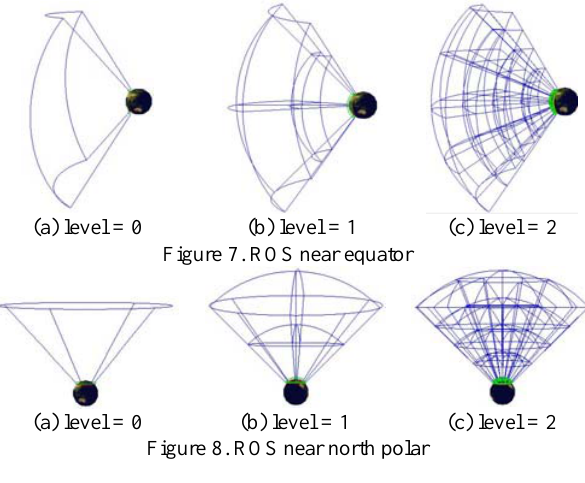
Figure 4. The partition curve surface corresponding to l -curve